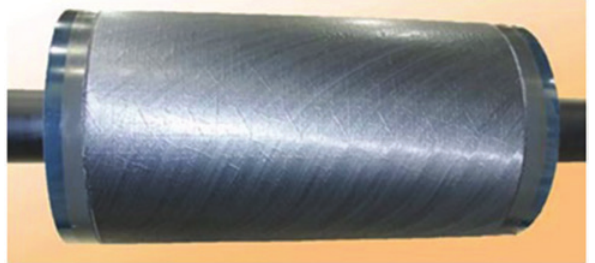
Figure 5: Variable stiffness cylinder during manufacturing. Reproduced from Blom et al.